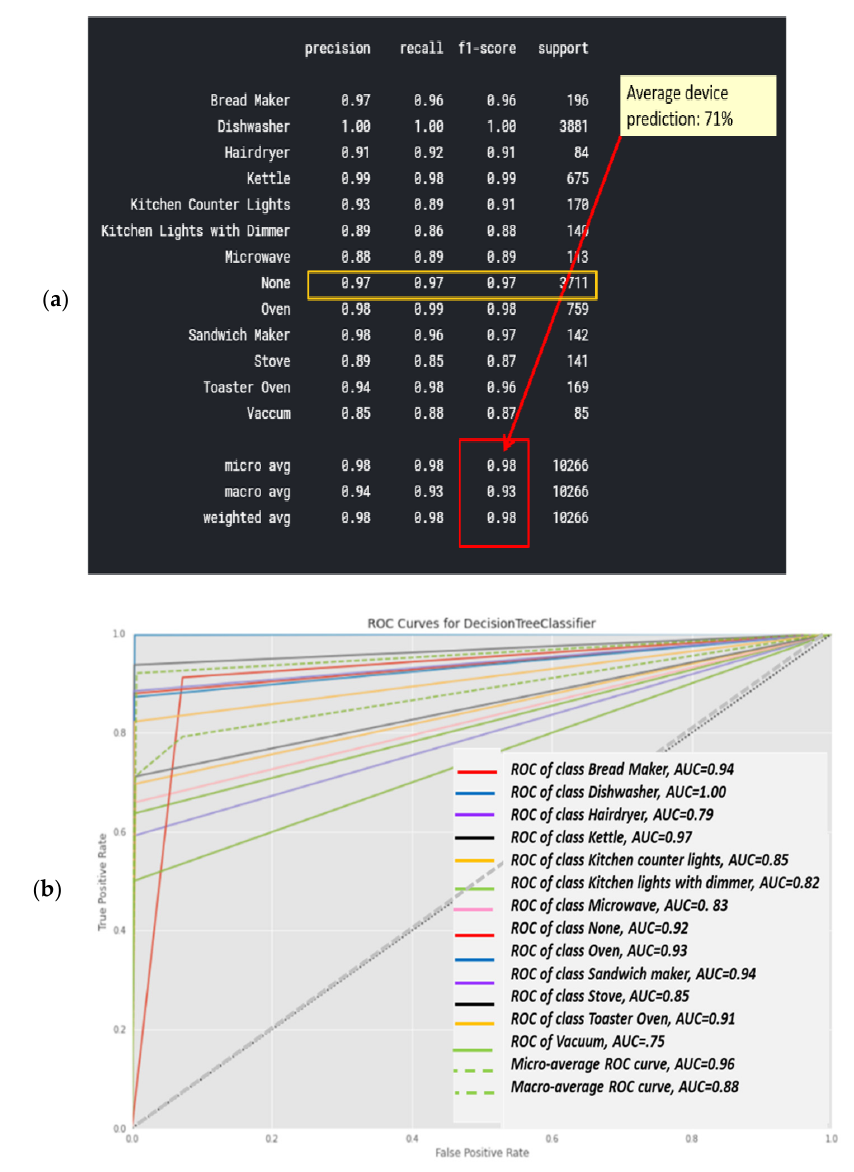
Figure 16. Decision tree classifier ( a ) classification report and ( b ) ROC-AUC curve.